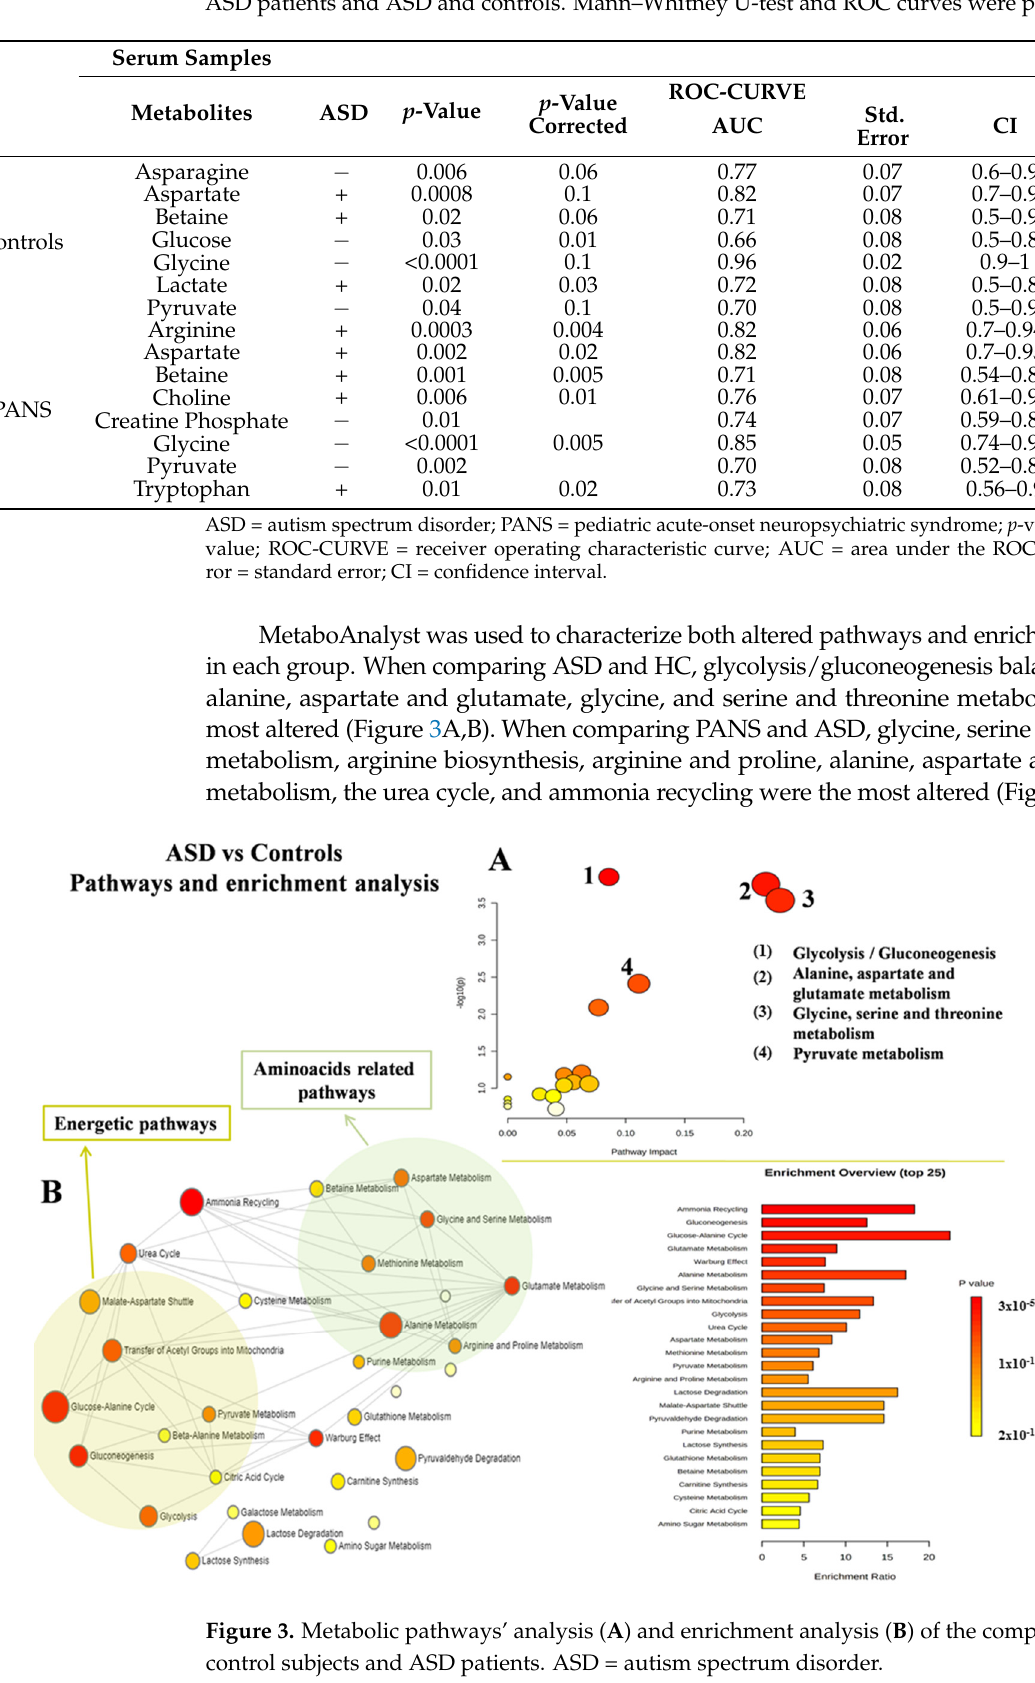
Table 3. Statistical parameters of the univariate analysis from the comparisons between PANS and ASD patients and ASD and controls. Mann–Whitney U-test and ROC curves were performed.